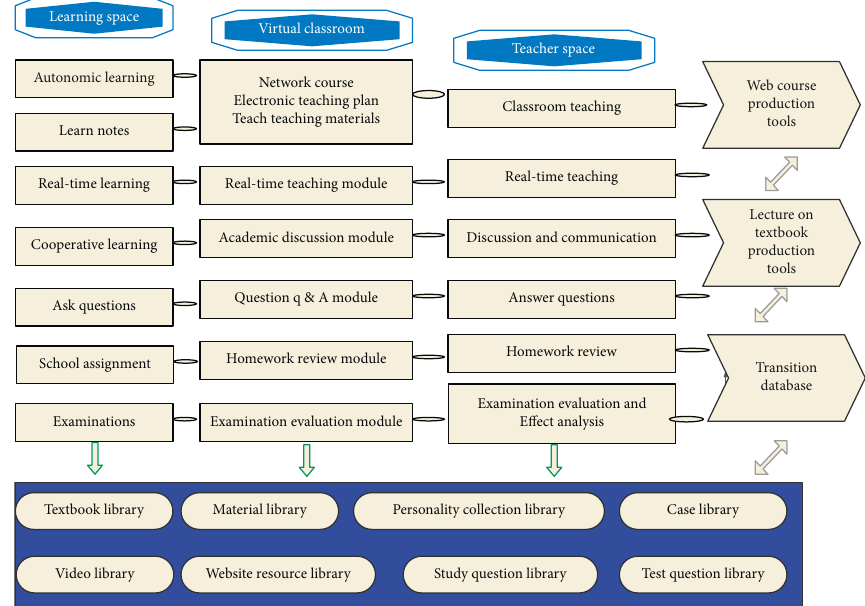
Figure 9: The functional structure of the media asset management